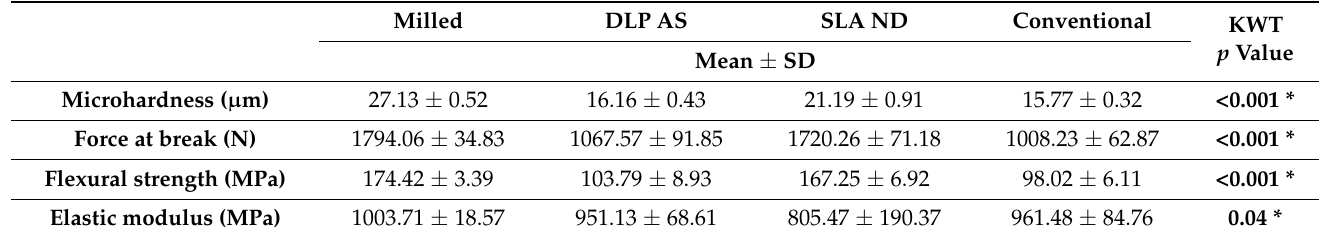
Table 2. Comparison of the mechanical properties between the studied materials.